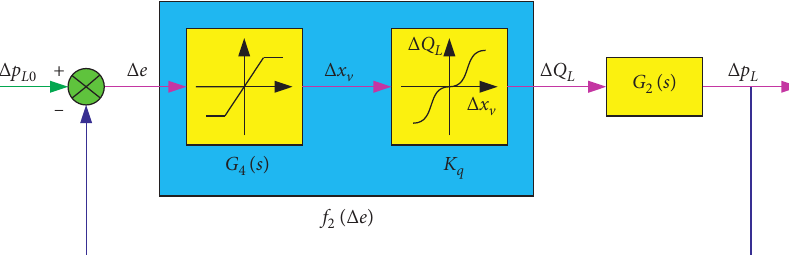
Figure 9: Transfer block diagram of the perturbation of PCL